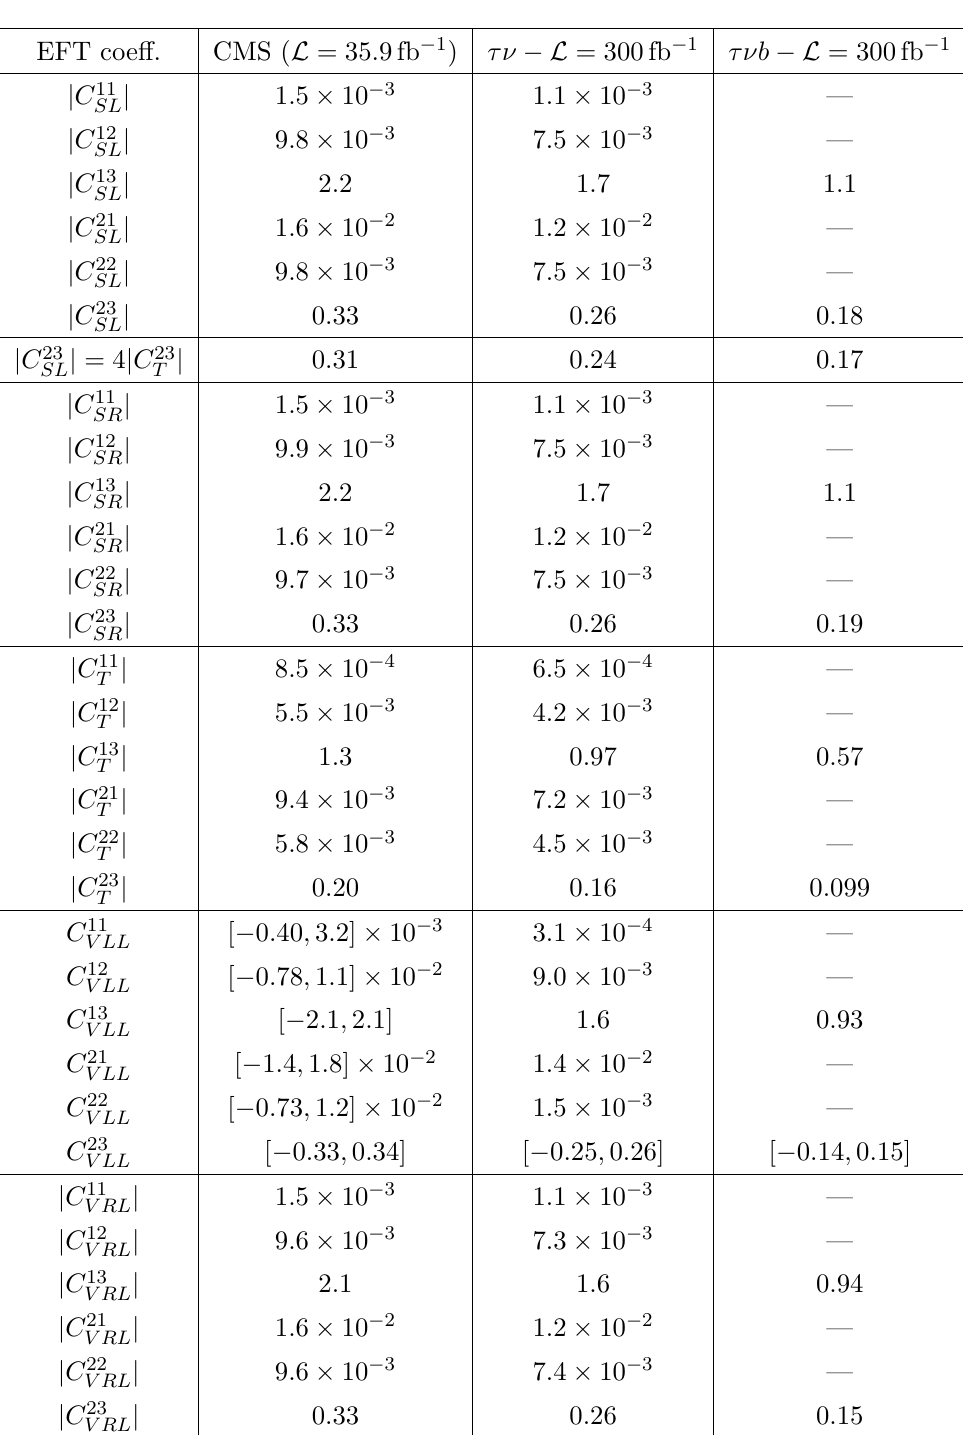
Table 4 . In the second column we show the recasted 95% CL intervals for the EFT coefficients defined in eq. (2.1), evaluated at the 1 TeV scale and switched on one at a time, using the CMS τν √ analysis at s = 13 TeV and an integrated luminosity of 35.9 fb − 1 . In the third and fourth column we show the prospects with a luminosity of 300 fb − 1 for the same τν analysis and τν + b -jet analysis we propose,